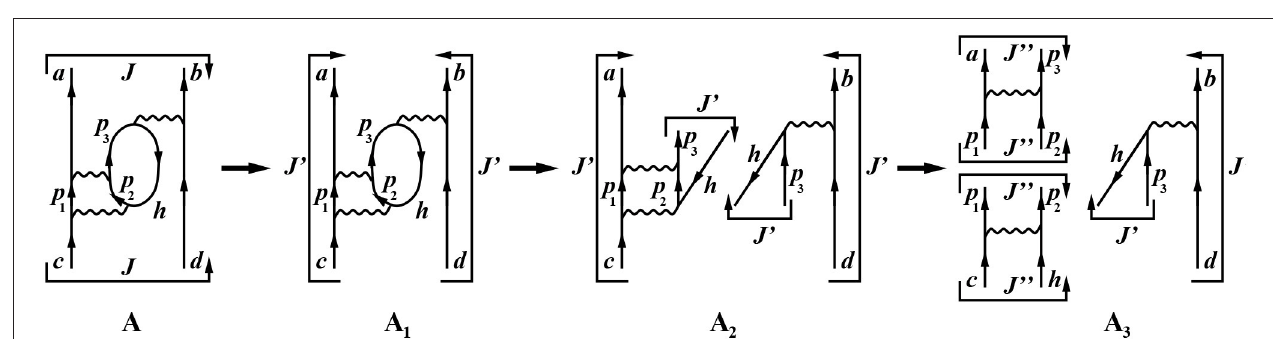
FIGURE 5 | Two-body 3 p -1 h diagram at third order in perturbation theory: lines with arrows represent incoming/outgoing and intermediate particle/hole states; wavy lines indicate interaction vertices.